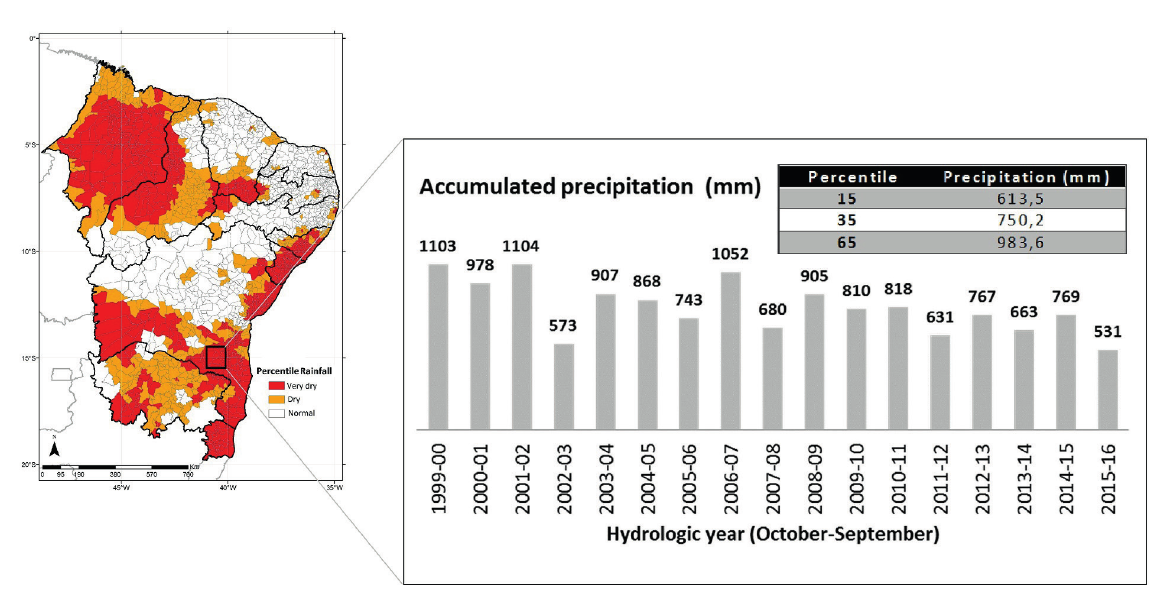
Figure 4 - Accumulated precipitation (mm) for a selected area characterized by a “Very Dry” condition (black box) for the period of 1999-2016, including the values of